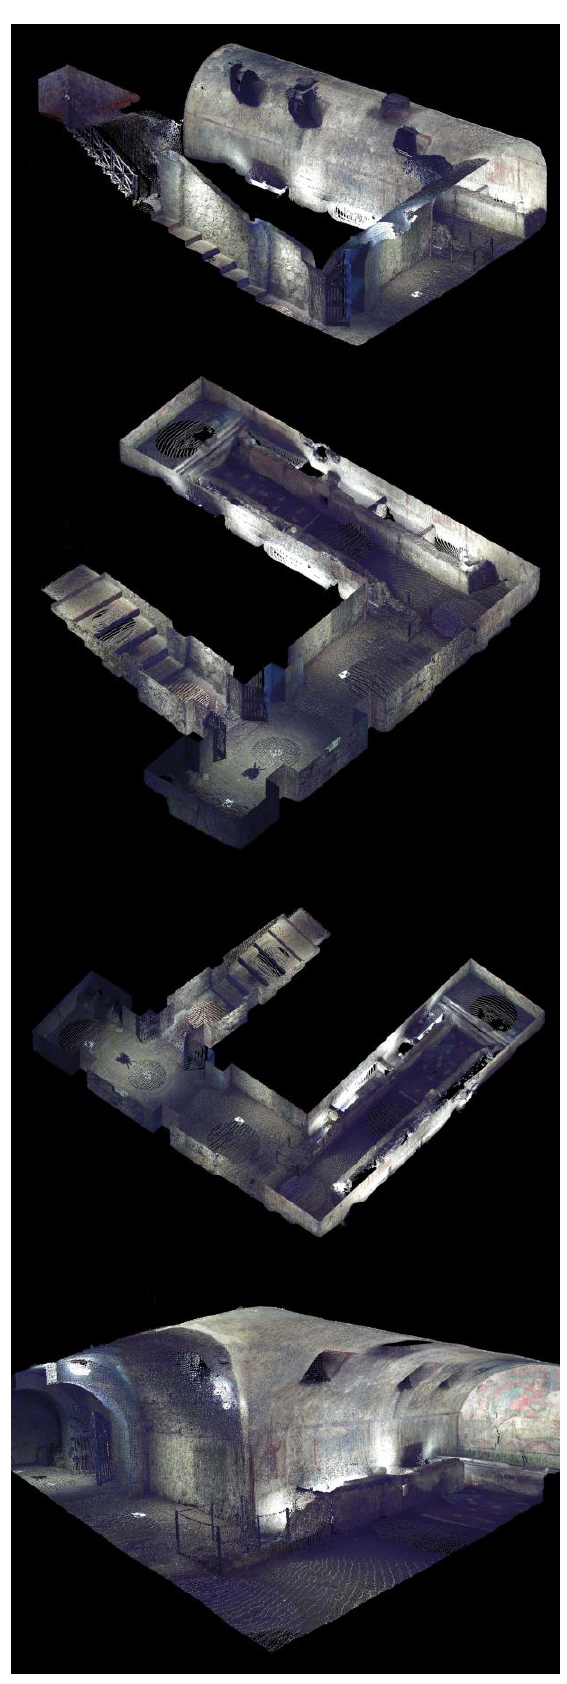
Figure 6. The cloud model has been developed to highlight different features of the